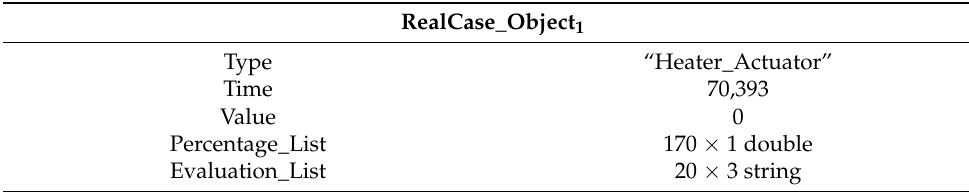
Table 22. RealCase object Example for the DCV and heating system.